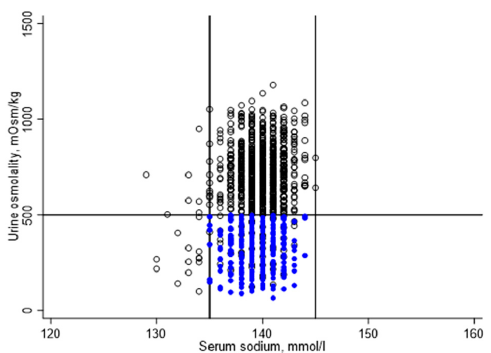
Figure 2. Distribution of serum sodium and urine osmolality in the study sample. Table 1. Characteristics of the study population in